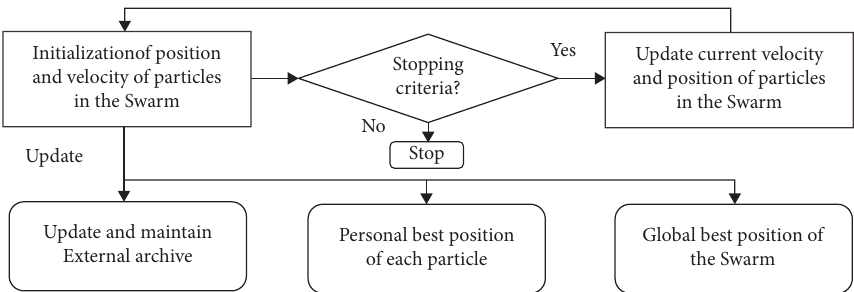
Figure 2: General framework of the proposed